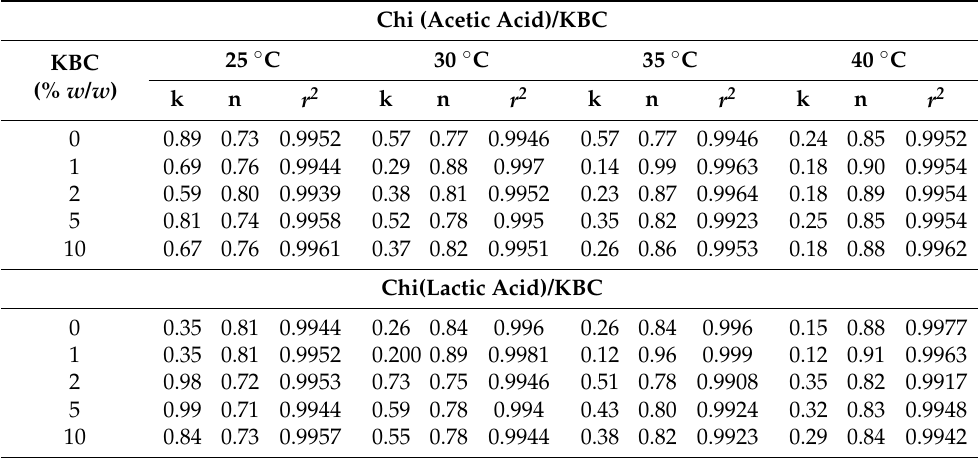
Table 4. The combined effect of temperature and KBC concentration on the viscosity of modified Chi